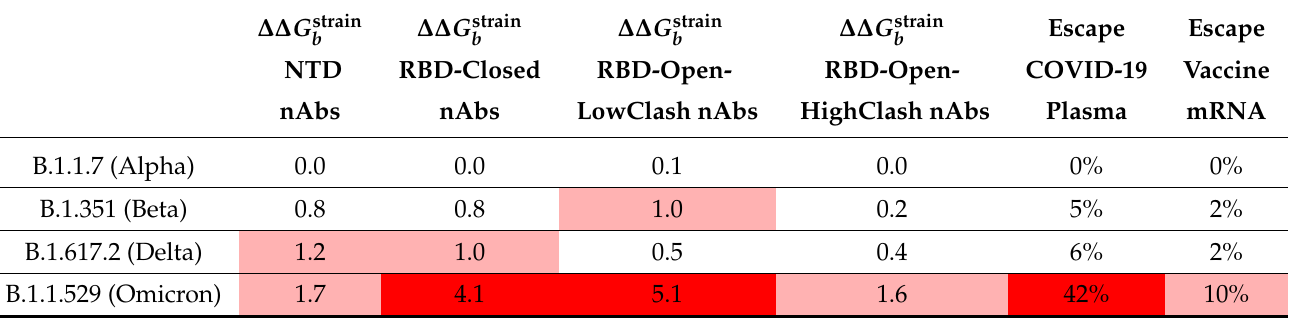
Table 2. Average predicted change in binding affinity ∆∆ G strain contained in the different classes and the spike protein of the SARS-CoV-2 viral strain (column 2–5) (see Section 2.4). The last two columns contain the value of the escape fraction of the viral strains estimated from plasma of COVID-19 patients [26] (column 6) and of healthy individuals vaccinated with mRNA-1273 [27] (column 7) (see Section 2.5). Averaged ∆∆ G strain are in red, between 1 and 3 kcal/mol in light red and lower than 1 kcal/mol in white. Escape fraction values are in red if they are bigger than 30%, in light red if they are between 10% and 30%, and in white below